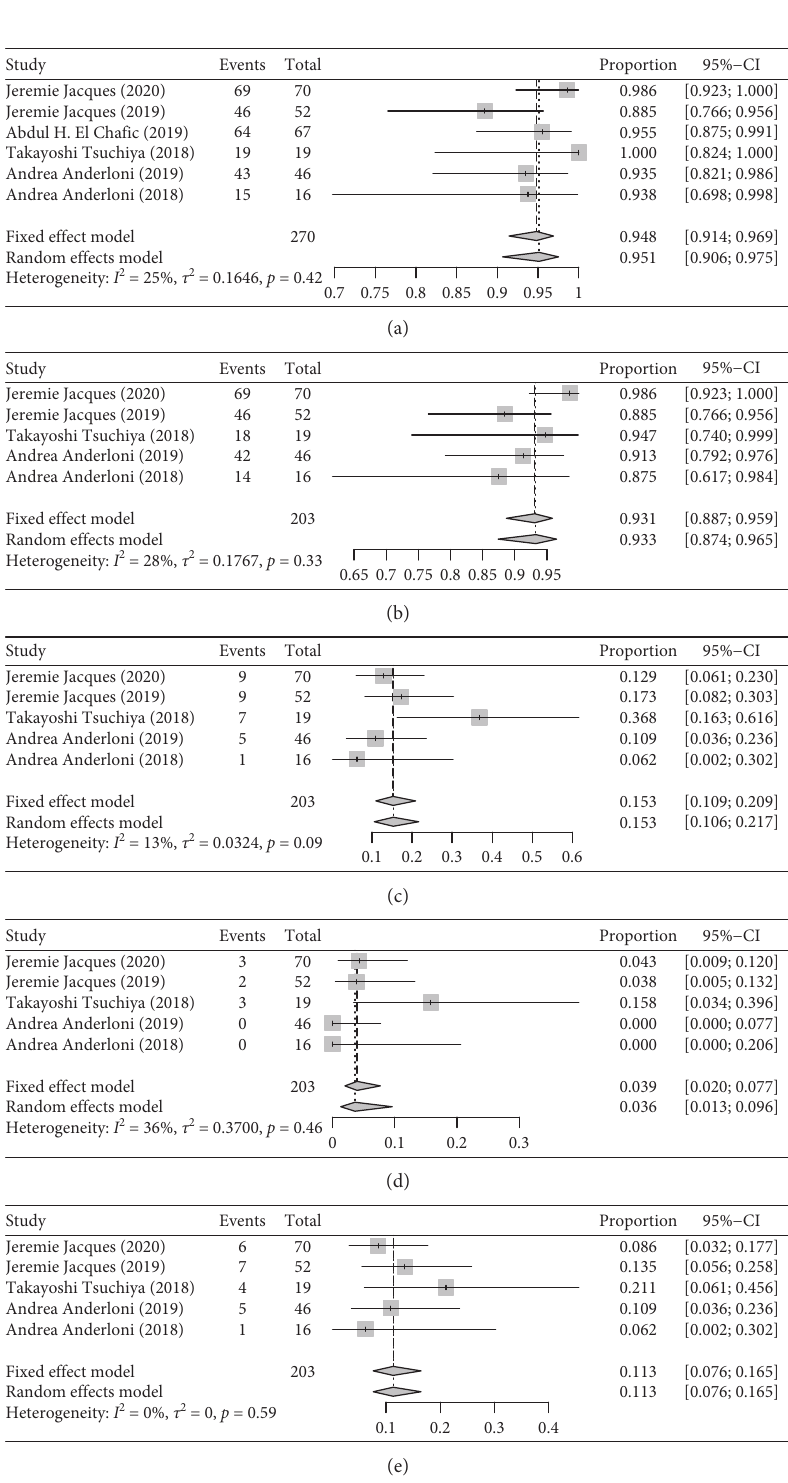
Figure 2: Forest plot clinical outcomes. (a) Technical success rate. (b) Clinical success rate. (c) Overall adverse event rate. (d) Short-term adverse event rate. (e) Long-term adverse event